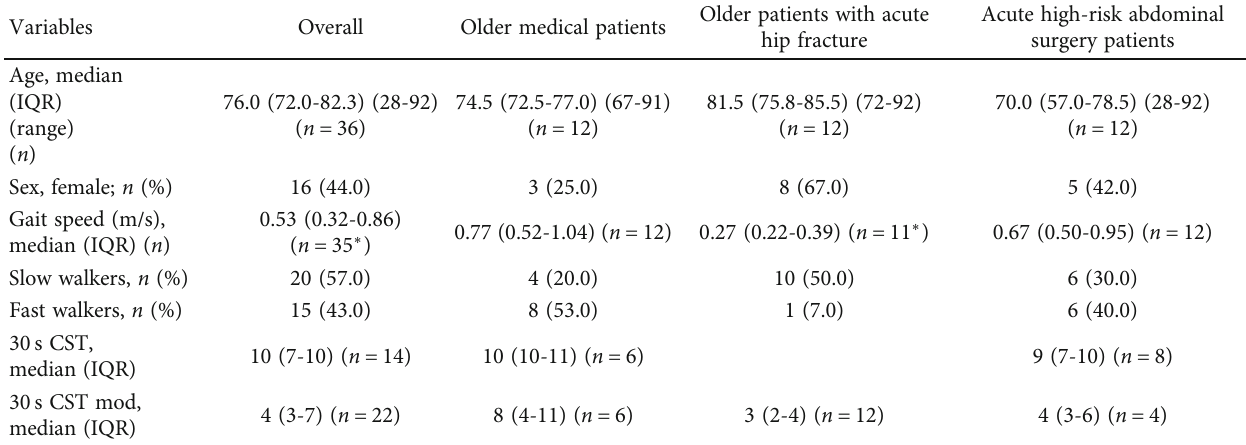
Table 2: Patient characteristics.